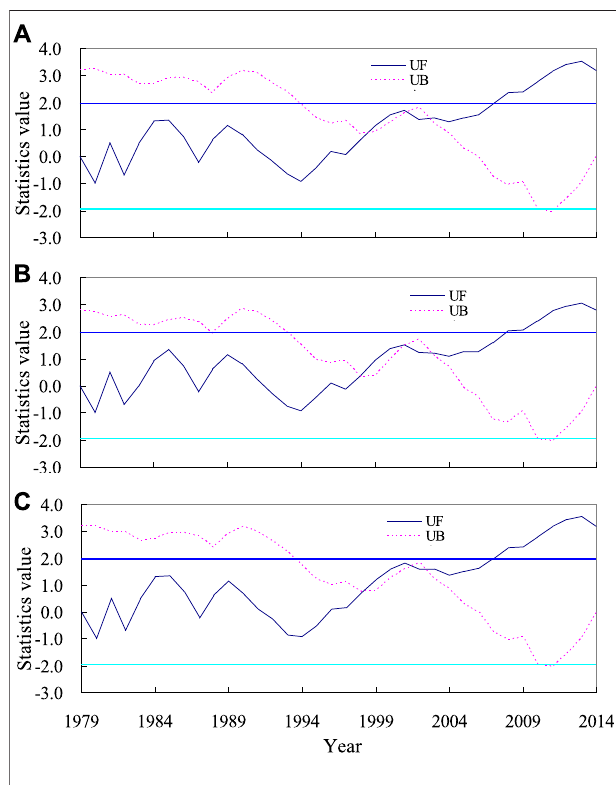
FIGURE 10 | M-K test of the WPD (A) , EWSO (B) , and RLO (C) in the low-latitude waters of the middle Paci fi c